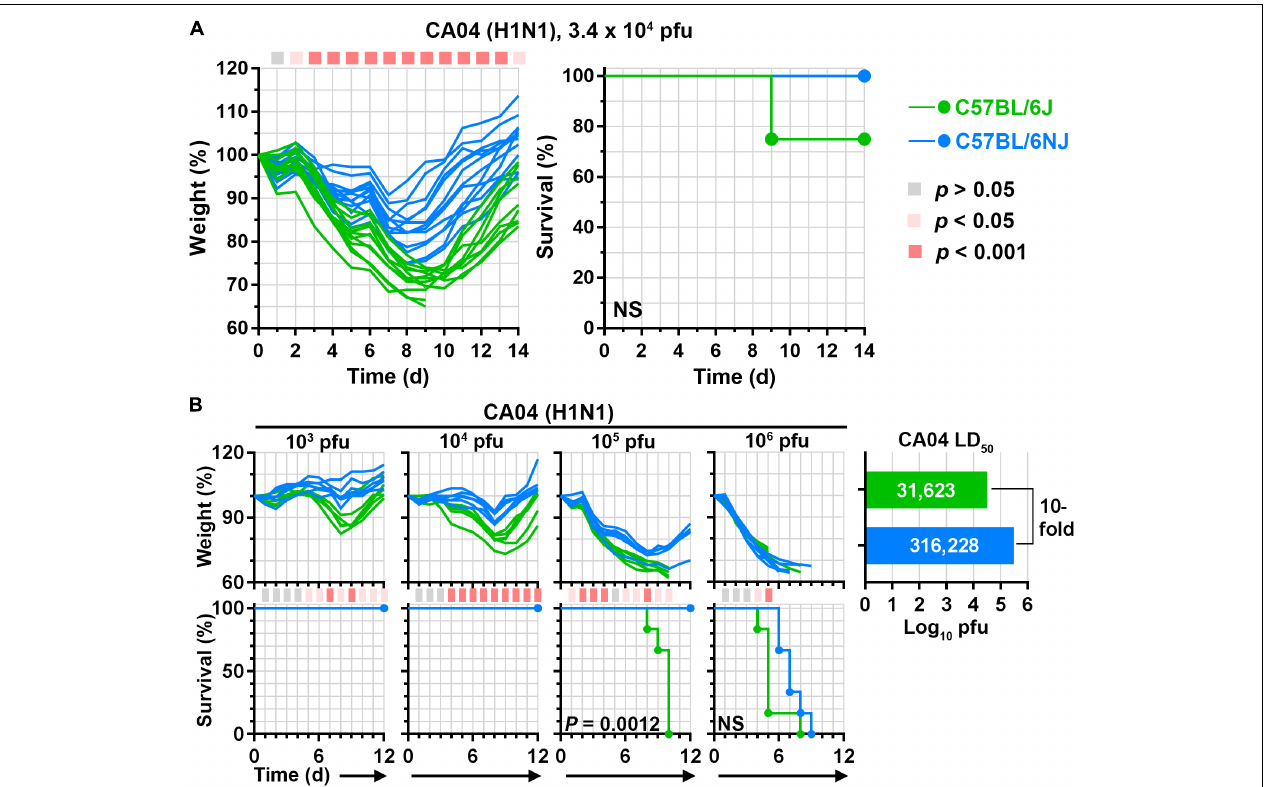
FIGURE 1 | C57BL/6J and C57BL/6NJ mice exhibit differential susceptibility to pandemic H1N1 influenza A virus disease. (A) Groups of C57BL/6J or C57BL/6NJ mice (12–13 mice for each strain) were intranasally infected with 3.4 × 10 4 plaque forming units (pfu) of influenza A/California/04/2009 (H1N1; ‘CA04’), and body weights and survival were monitored for 14 days. Body weight ratio profiles (that is, weight at a given time point/weight immediately prior to infection) of individual mice are shown, and the colored square corresponding to each time point (at the top of the graph) indicates whether a statistically significant difference was observed between C57BL/6J and C57BL/6NJ mice. Survival curves are not significantly different. NS, not significant; d, day. (B) Groups of six C57BL/6J or C57BL/6NJ mice were intranasally infected with serial dilutions of CA04 and body weight ratios and survival were monitored for 12 days. Body weight ratios and significance are shown as in (A) , except colored squares indicating statistical significance are shown at the bottom of the weight loss panels. For survival curves that significantly differ between C57BL/6J and C57BL/6NJ mice, p -values are given on the survival curve panel. Median lethal dose (LD 50 ) values were calculated for each mouse strain by using the Reed and Muench method (Reed and Muench, 1938), and are shown in the plot at the